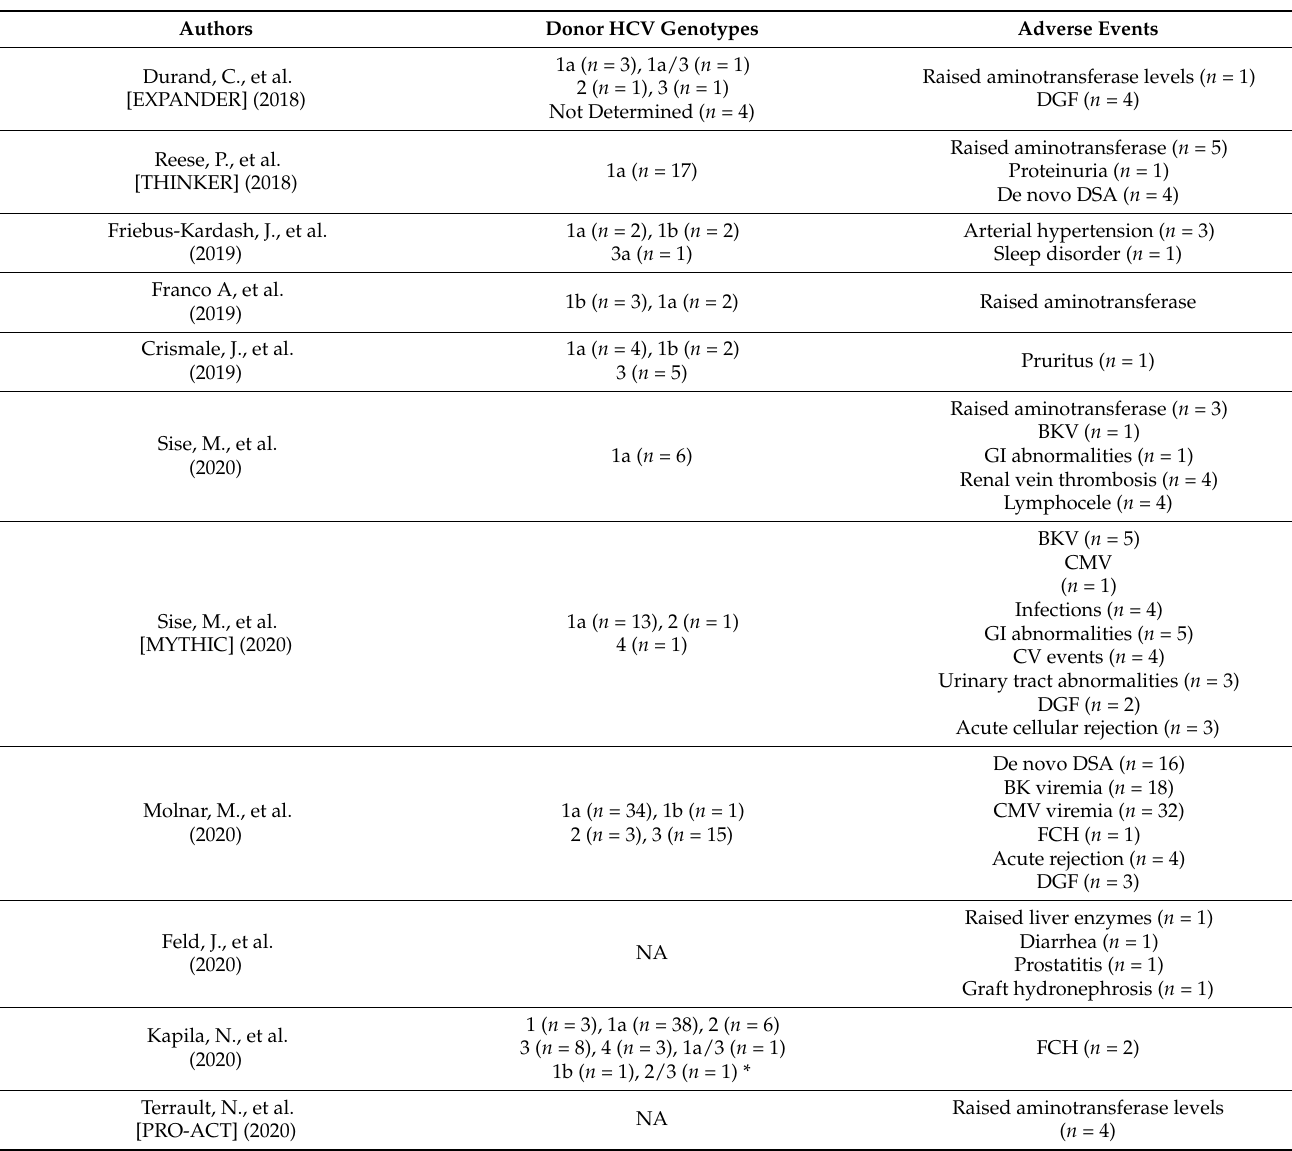
Table 4. Transplantation from kidney donors with HCV-viremia into HCV-negative kidney recipients and DAAs: clinical